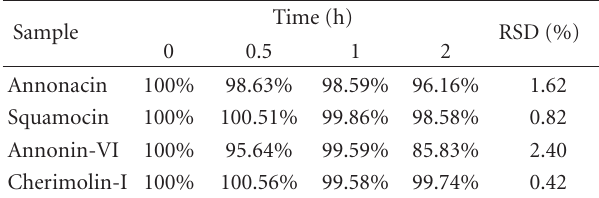
Table 2: Stability of ACGs in K-R bu ff er solution ( n =